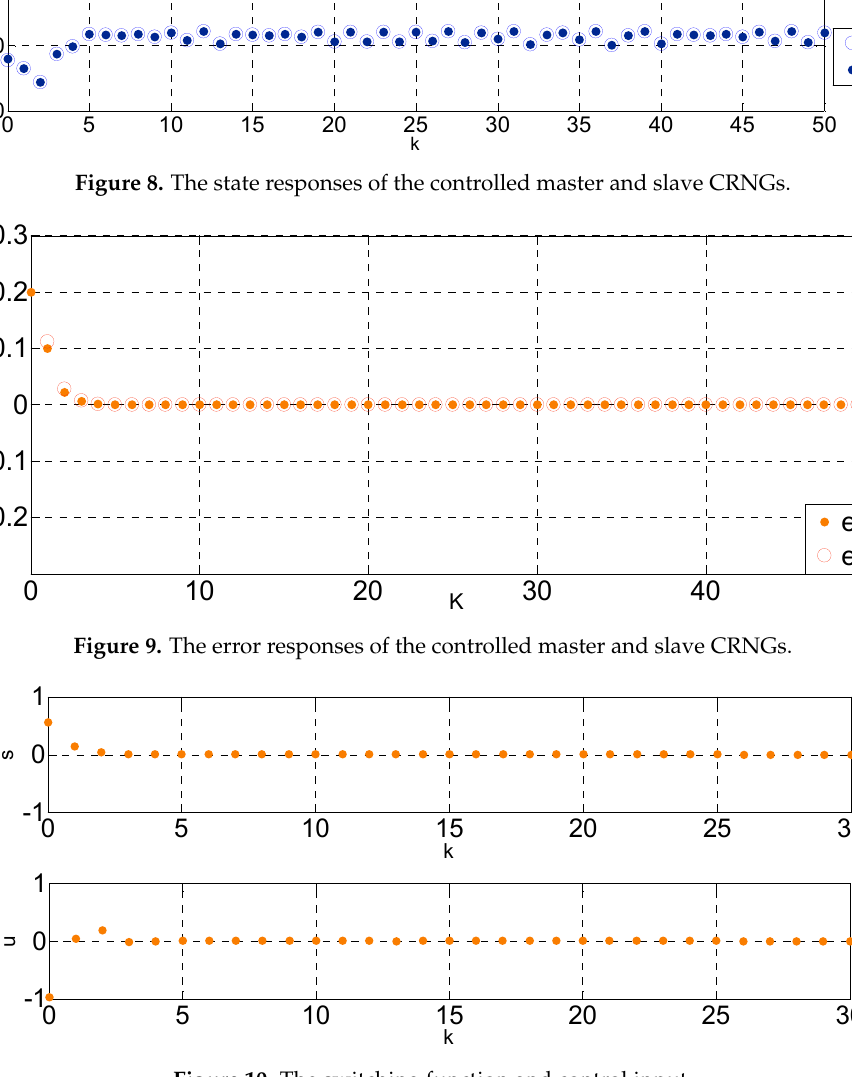
Figure 10. The switching function and control input.